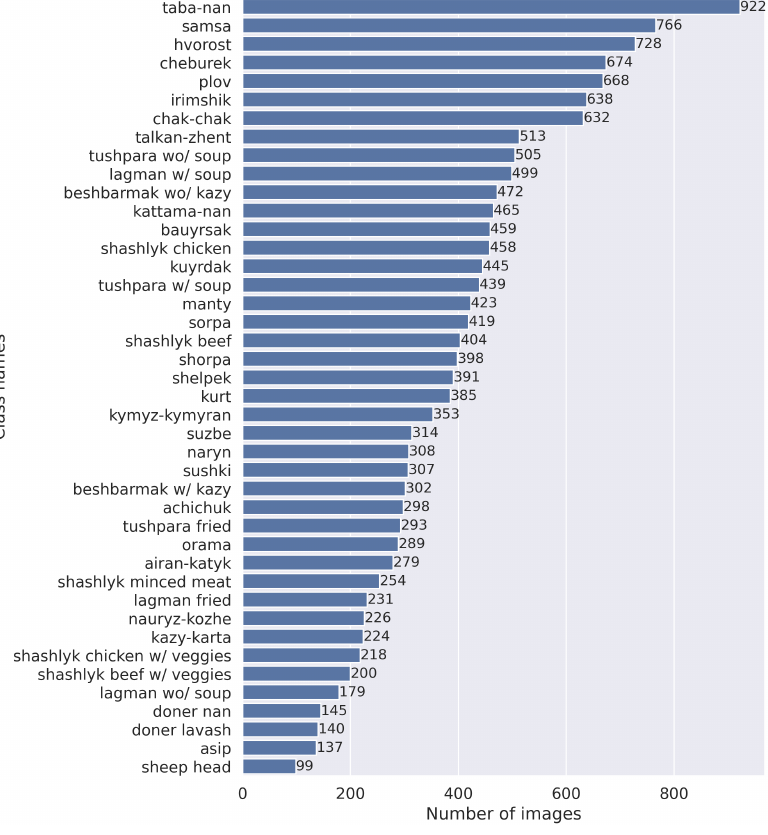
Figure 3. CAFD statistics by